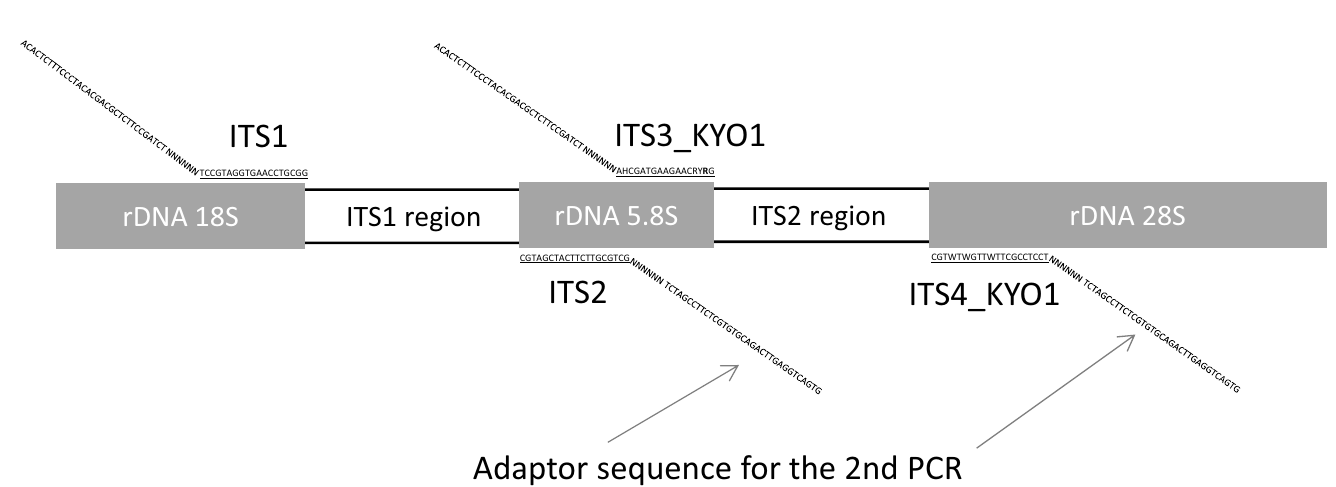
Fig 2. Map of ribosomal DNA genes with universal primers. The internal transcribed spacer 1 (ITS1) and 2 (ITS2) regions were targeted to identify causative species. The primer sets ITS1/ITS2 and ITS3_KYO1/ITS4_KYO1 were used as universal primers for the MiSeq system.